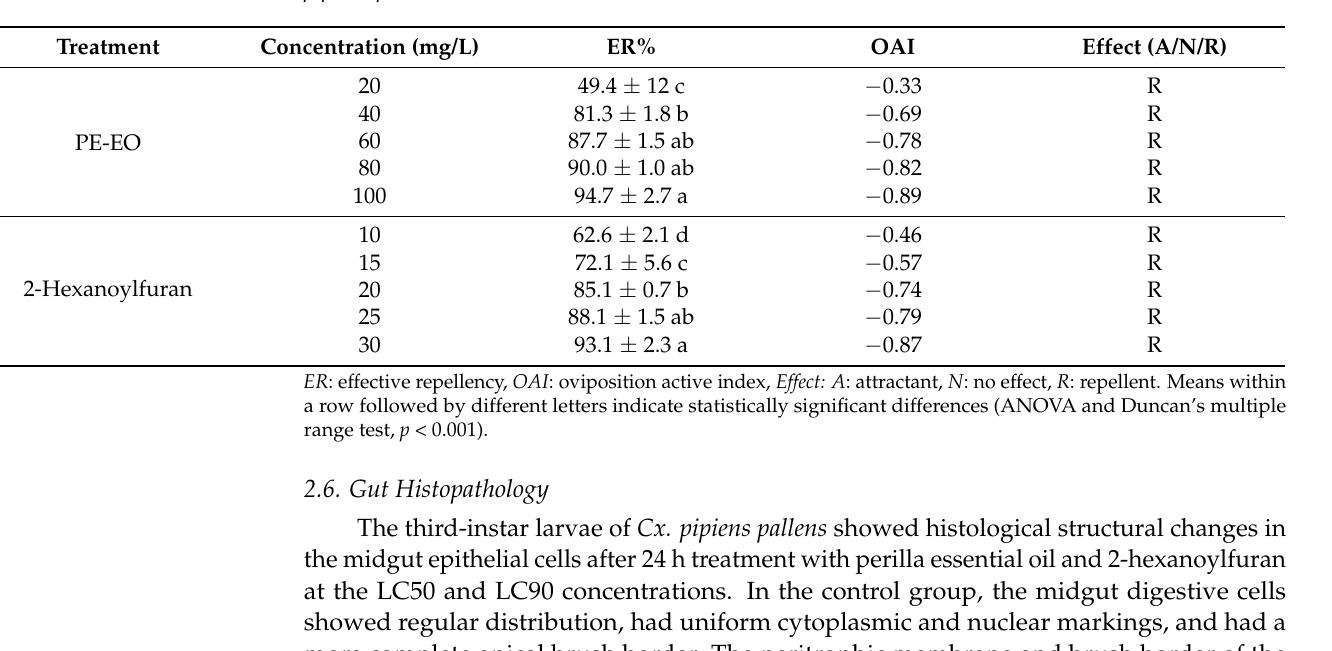
Table 3. Oviposition activity of perilla essential oil (PE-EO) and 2-hexanoylfuran against Culex pipiens pallens .